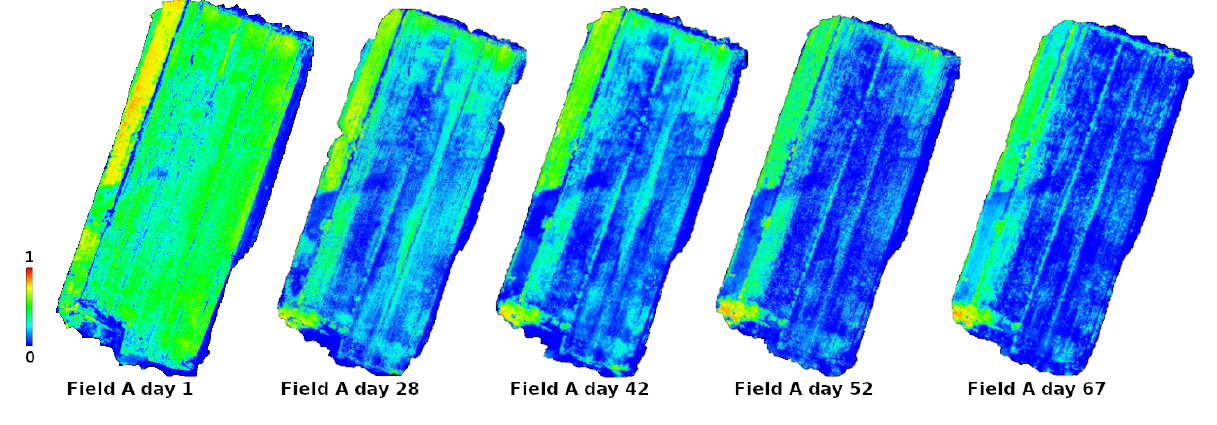
Figure 4. NDVI orthorectified heat maps’ evolution over time. Warmer colors represent higher NDVI values, ranging from 0 to 1, as we monitored vegetation evolution.